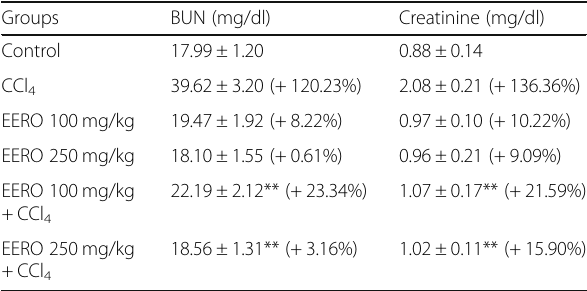
Table 1 Effect of ethanolic extract of upper shoot of Rosmarinus officinalis (EERO) on BUN, urea, and creatinine in CCl 4 -induced nephrotoxicity in rats Groups